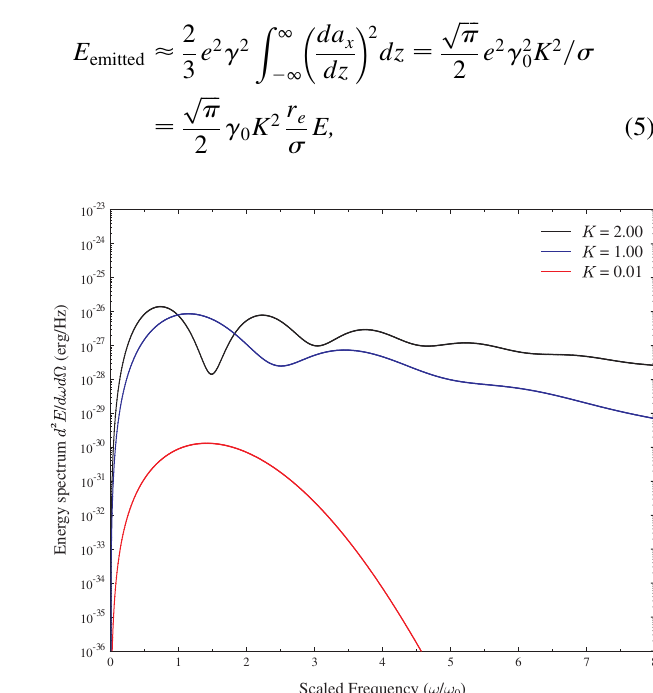
FIG. 1. (Color) Effective motion spectrum for wide-band source. FIG. 2. (Color) Forward energy spectrum for wide-band